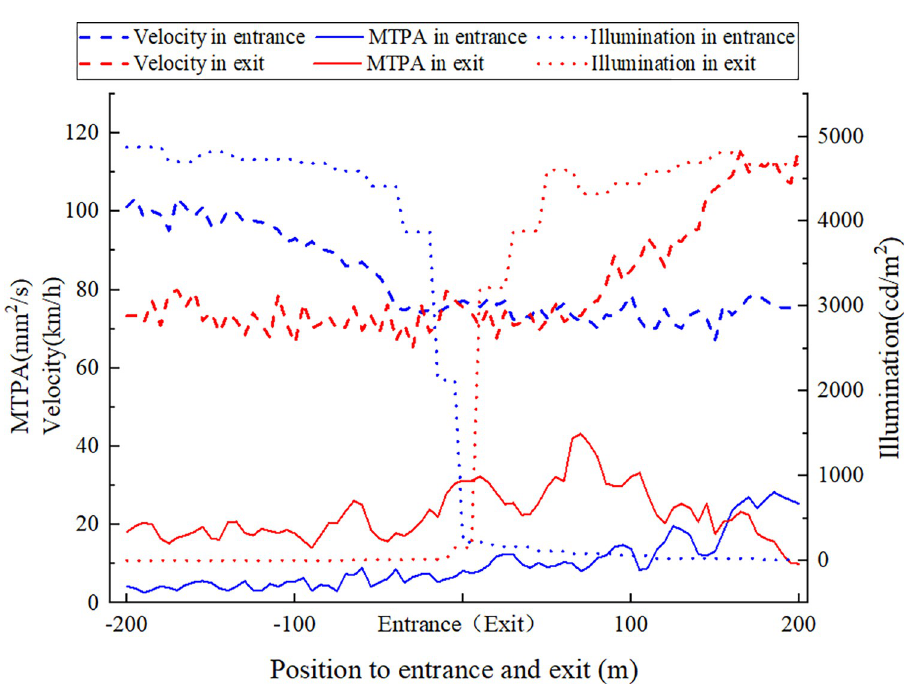
Fig 6. Velocity, illumination and MTPA of driver when passing through the extra-long